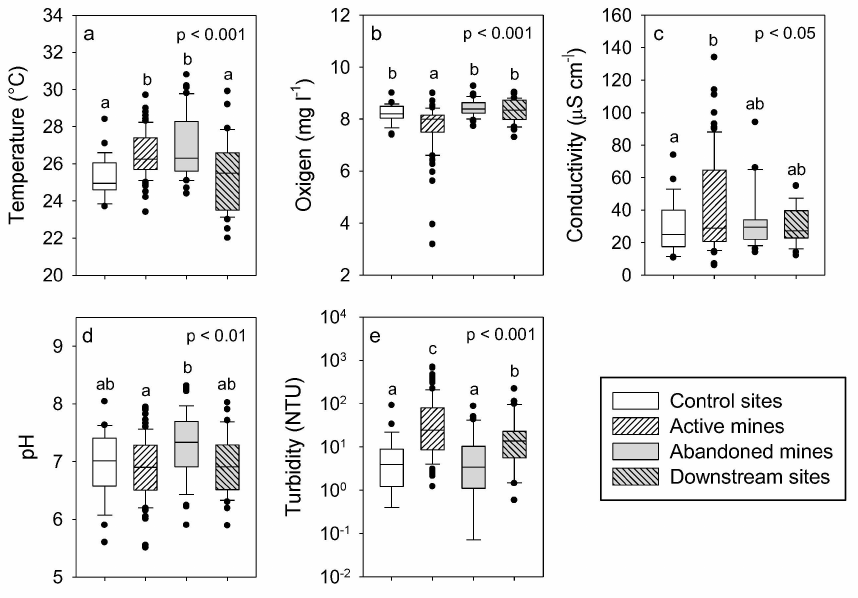
Figure 2. Boxplots of physical and chemical variables at the study sites ( a ) = Temperature, ( b ) = Dissolved oxygen, ( c ) = Electrical conductivity, ( d ) = pH and ( e ) = Turbidity. Results of one- factor ANOVAs (location) and multiple comparisons with Tukey test are also shown. There are no significant differences among locations with the same letter. Mean values and statistical analyses are detailed in Tables A1 and